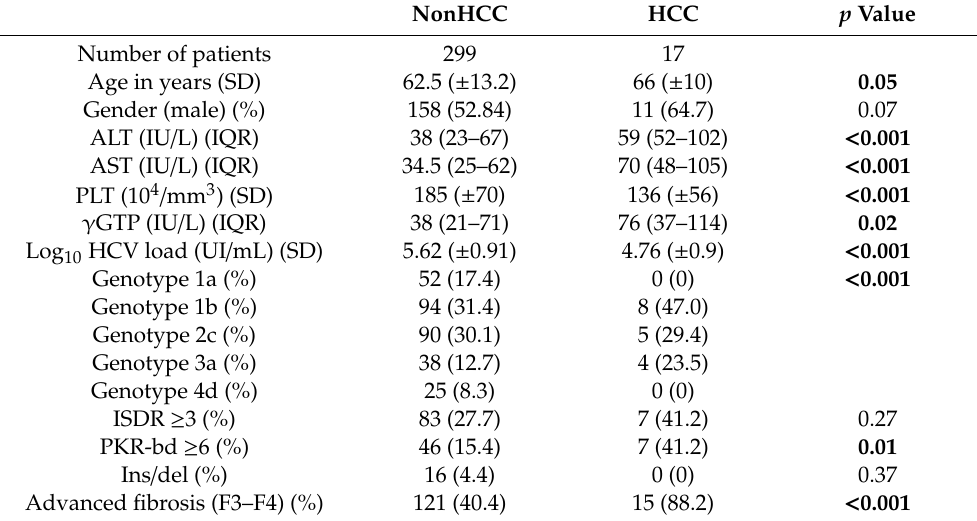
Table 3. Baseline clinical characteristics of patients treated with direct-acting antiviral drugs (DAAs) according to development in hepatocellular carcinoma